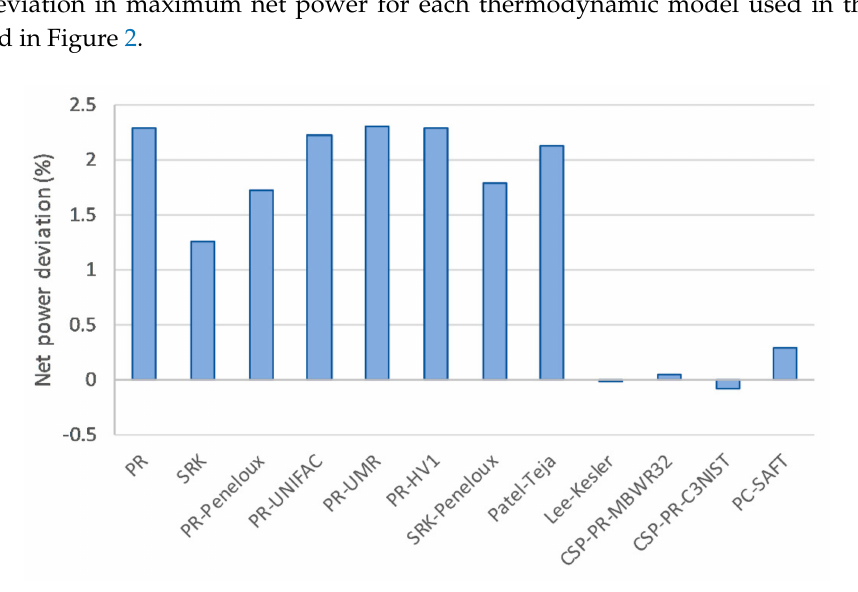
Figure 2. Deviation in maximum net power relative to the results from using the Groupe Europ é en de Recherches Gazi è res (GERG) equation of state